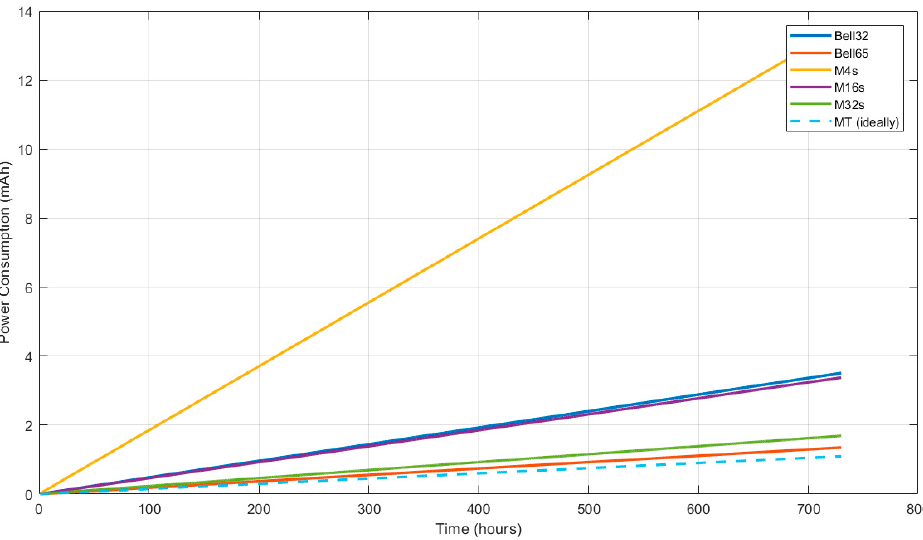
Figure 18. Consumption trend analysis during a month of operation for each configuration.